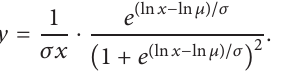
Figure 10: Value of